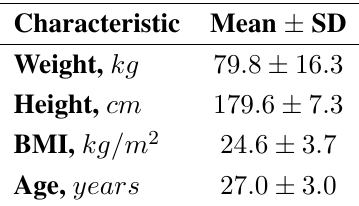
Table 1. Subjects’ physical characteristics (n =